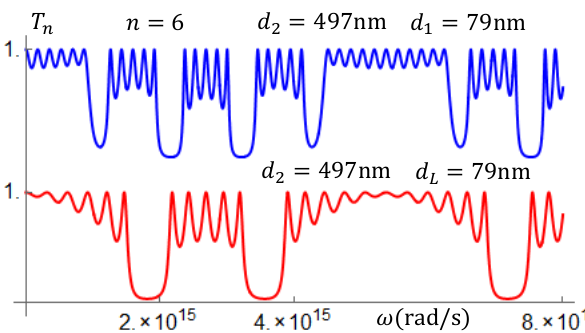
Figure 8. The transmission coefficients for two superlattices air ( RR ) n air (upper panel) and air ( LR ) n air (lower panel), with the same parameters except for the signs of the refraction indices (cid:101) 1 and µ 1 . For the upper panel, we have n = 6, n 1 = 2.22, n 2 = 1.41, d 1 = 79 nm, and d 2 = 497 nm. For the lower panel, we have n =6, n 1 = − 2.22, n 2 = 1.41, d 1 = 79 nm, and d 2 = 497 nm.